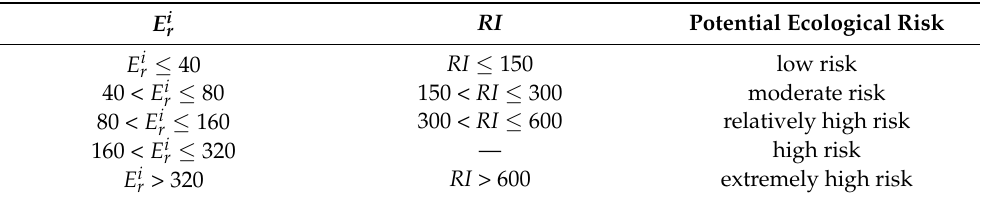
Table 1. The classification criterion of the potential ecological risk index E i r and potential ecological risk index ( RI